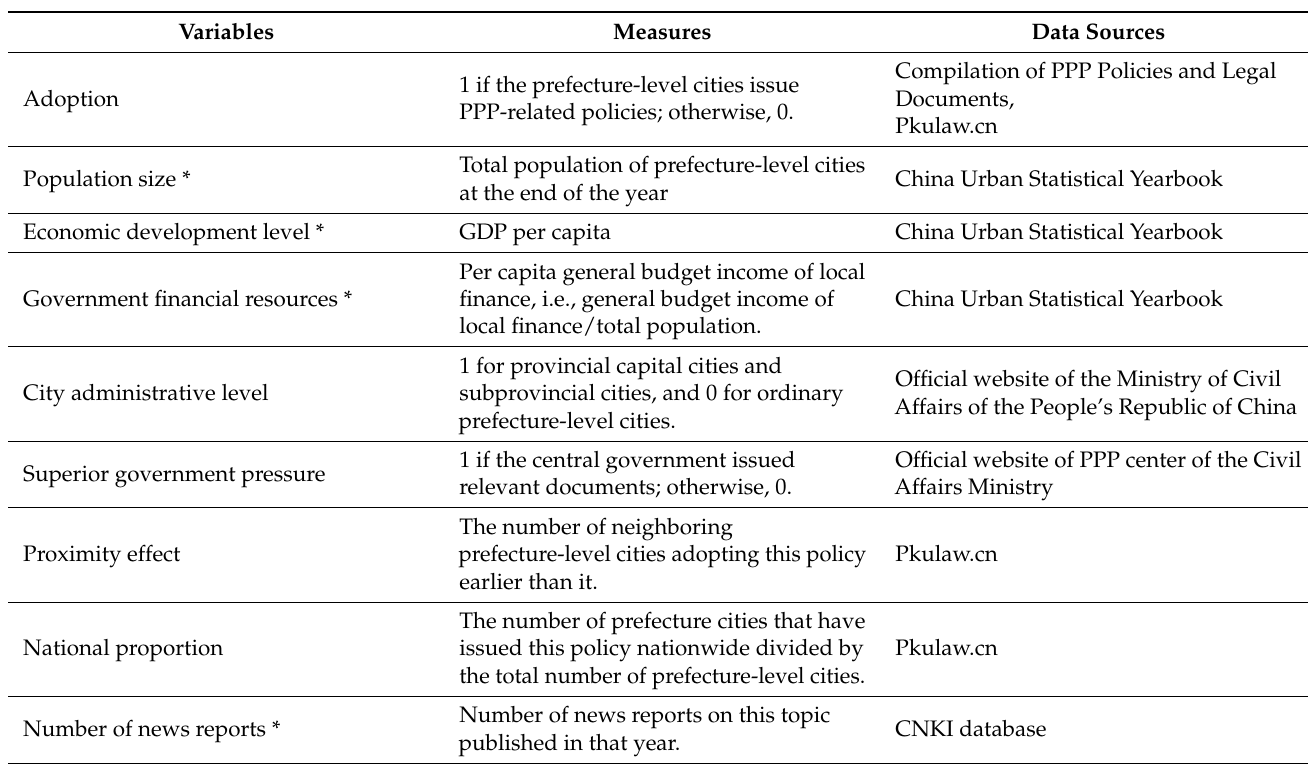
Table 1. Variable setting and data